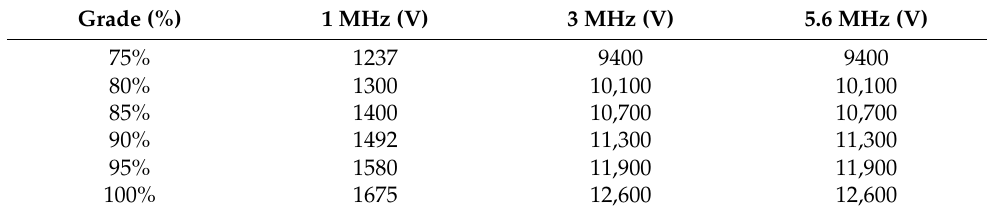
Table 1. The voltages of signals.